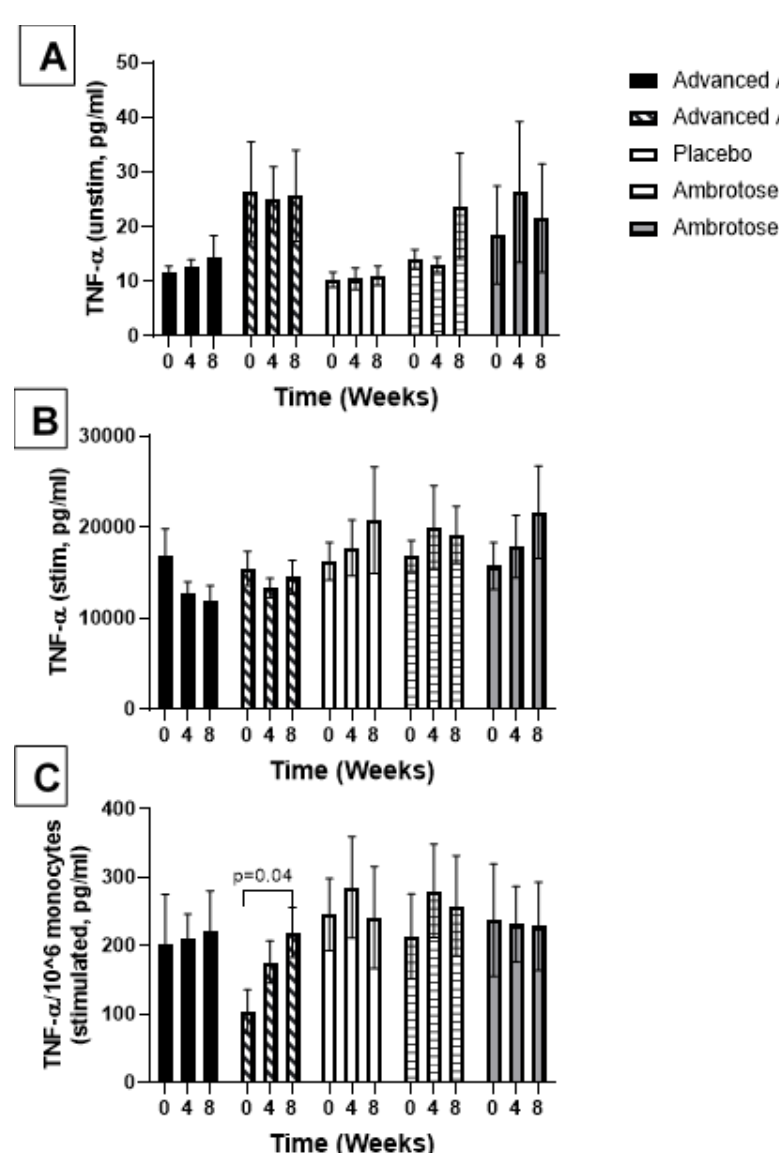
Figure 3. Plasma TNFα without stimulation ( A ) and with lipopolysaccharide stimulation ( B ). ( C ) Stimulated samples are normalized to monocyte numbers. Values are mean ± SEM, n = 15 per group. Significant changes are indicated where p < 0.05.